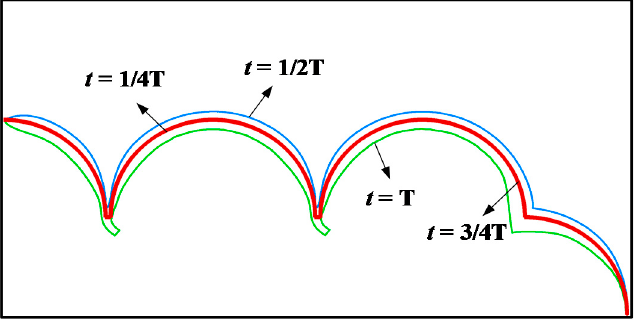
Figure 6. Process of pulmonary acini respiration.